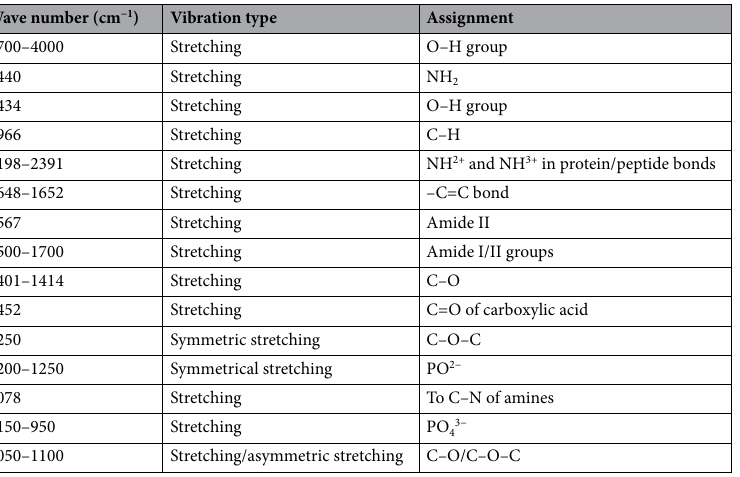
Table 1. FTIR peaks assignments and their corresponding functional groups associated with FCNPs, FFNPs and